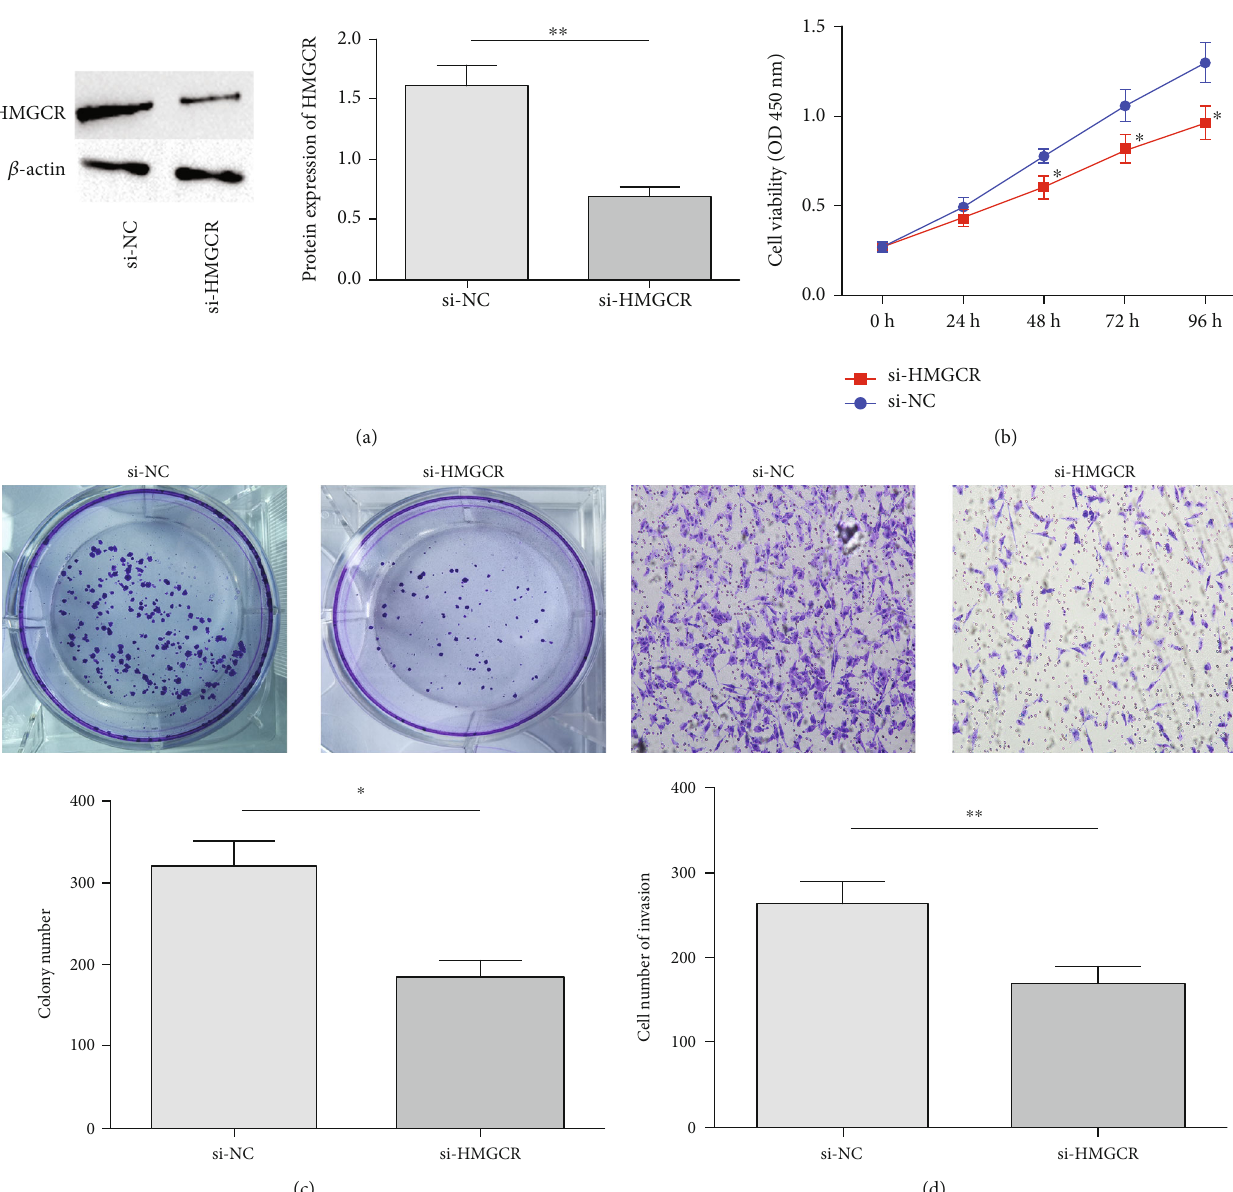
Figure 6: Impact of HMGCR on biological function of PC cells. (a) HMGCR expression; (b) cell viability detection; (c) plate clonal cell formation; (d) cell invasiveness; ∗ P < 0 : 05 ; ∗∗ P < 0 : 01